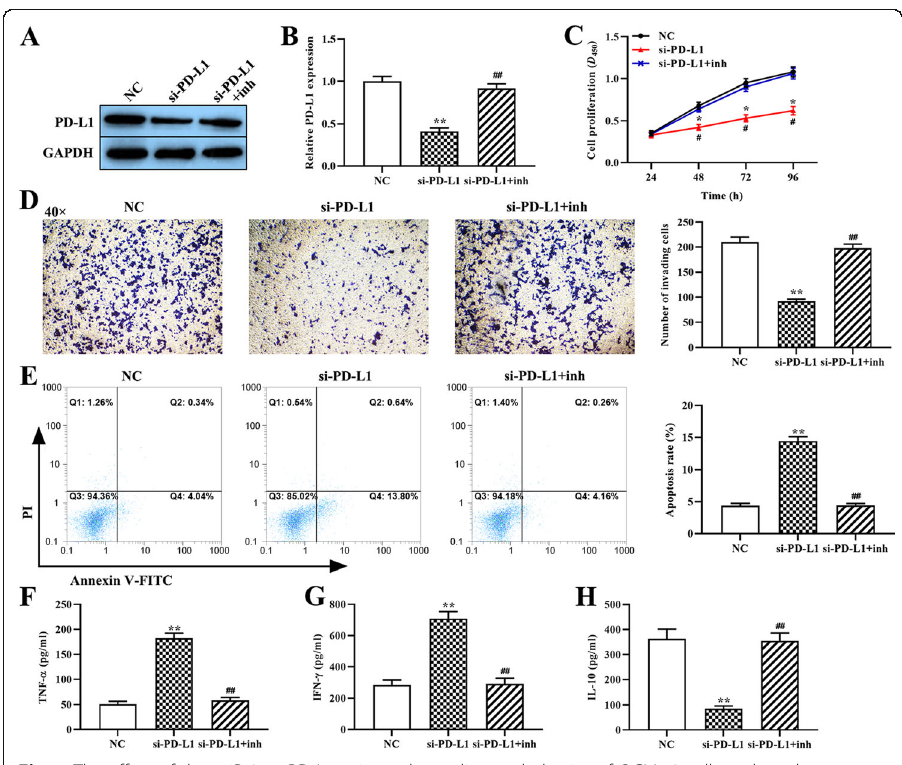
Fig. 4 The effect of the miR-214 – PD-L1 axis on the malignant behavior of OCI-Ly3 cells and on the cytokine secretion from T cells. ( a and b ) The expression of PD-L1 protein was determined using western blot. ( c ) The proliferation of OCI-Ly3 cells was determined using the CCK-8 assay. ( d ) The invasion ability of OCI-Ly3 cells was assessed using the Transwell assay (magnification, × 40). ( e ) The rate of OCI-Ly3 cell apoptosis was measured using flow cytometry. ( f through h ) The expression levels of TNF- α , IFN- γ and IL-10 were measured using ELISA. si-PD-L1: PD-L1 siRNA; si-PD-L1 + inh: PD-L1 siRNA + miR-214 inhibitor. *p < 0.05, **p < 0.01, compared with the NC group; # p < 0.05, ## p < 0.01, compared with the si-PD-L1